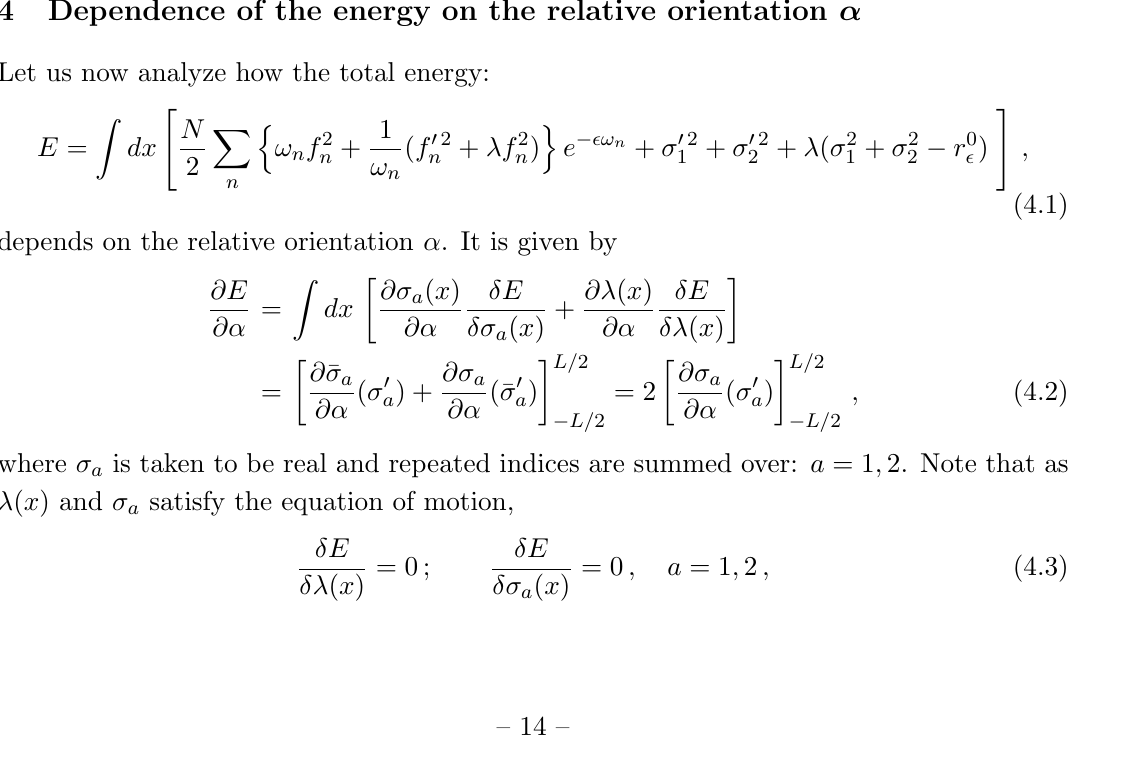
(above the two 4 (below the same two diagonal 4